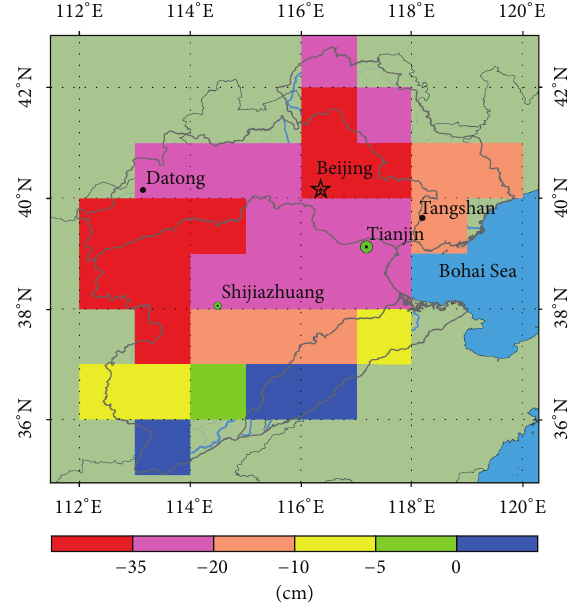
Figure 5: Spatial distribution of accumulated TWS anomalies during the period from October 2011 to March 2012 for drought risk